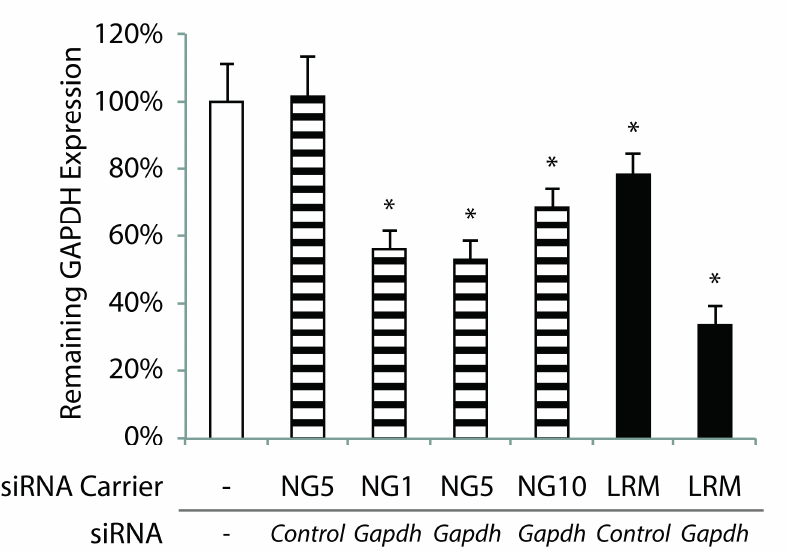
Figure 2. GAPDH knockdown in MC3T3 cells by siRNA delivery. Nanogel NSP